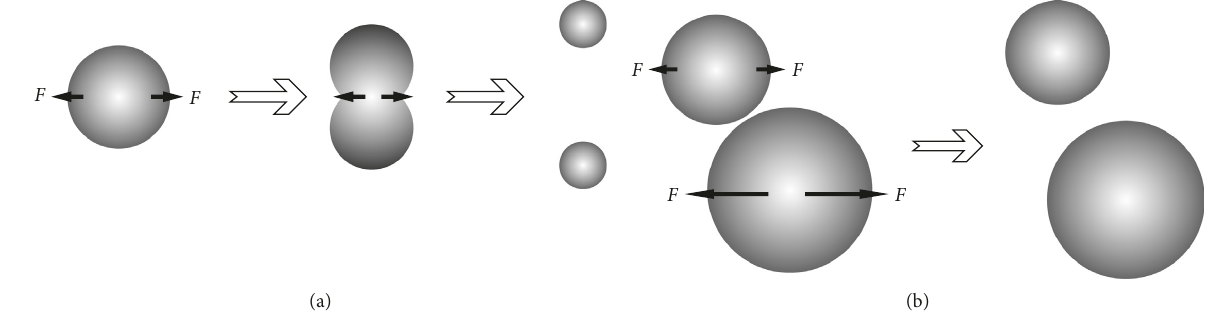
Figure 5: Particle condensation process under the influence of electromagnetic